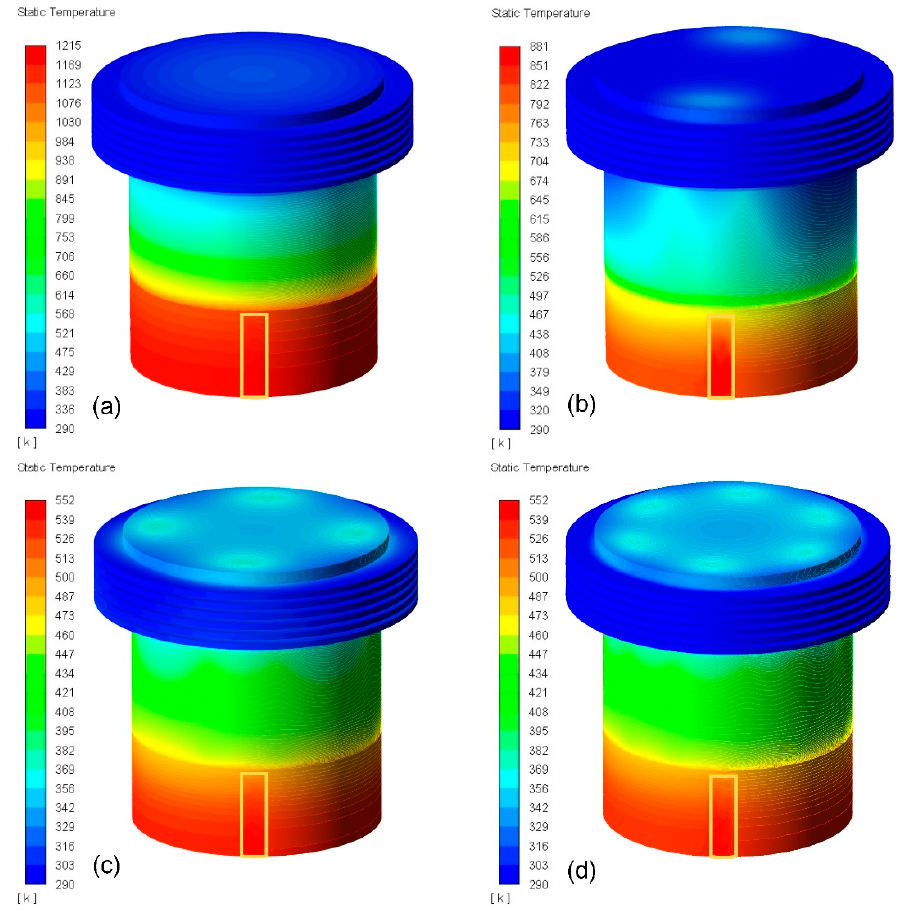
Figure 9. Temperature distribution on the grinding wheel under a grinding heat flux of 10 7 W / m 2 : ( a ) 0 OHP, ( b ) 2 OHPs, ( c ) 4 OHPs and ( d ) 6 OHPs (Temperature unit: K).